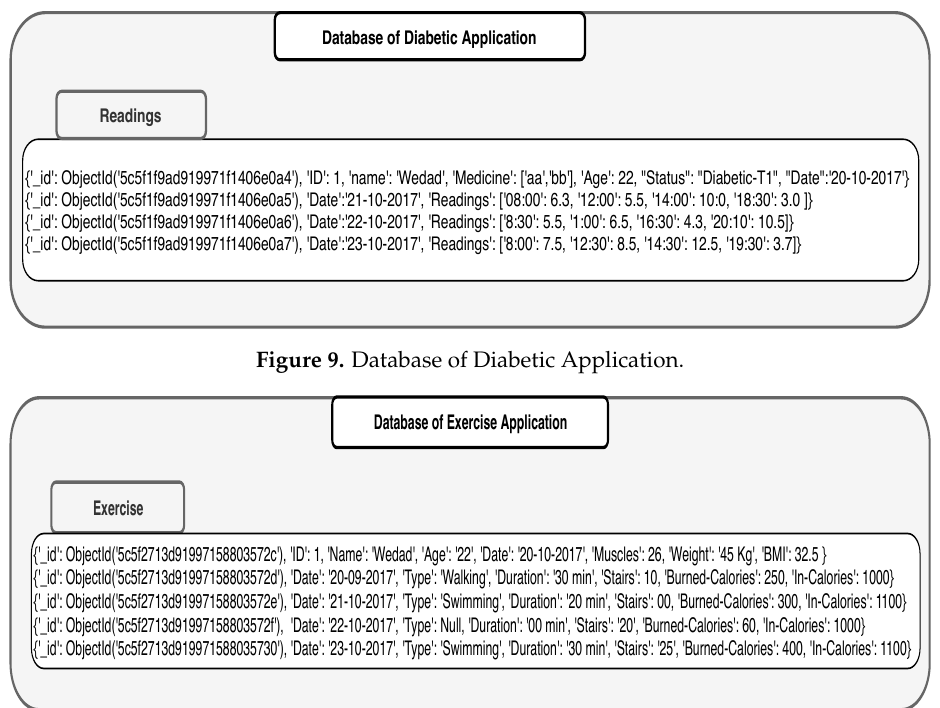
Figure 10. Database of Exercise